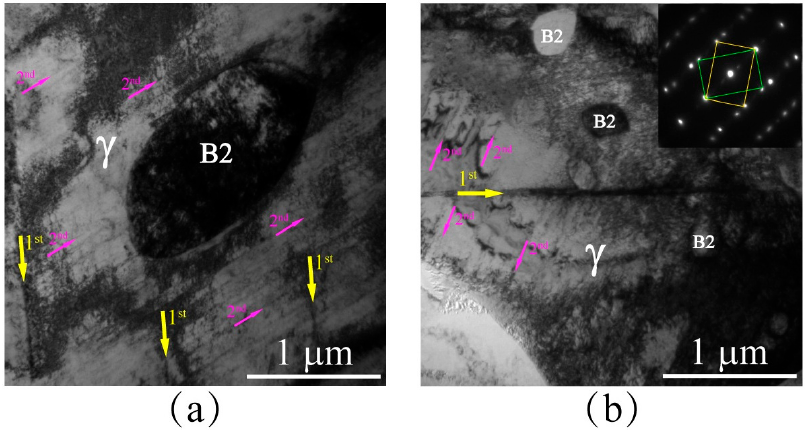
Figure 8. TEM images for ( a ) sample after testing at strain rate of 0.0006/s; ( b ) sample after testing at strain rate of 56/s.